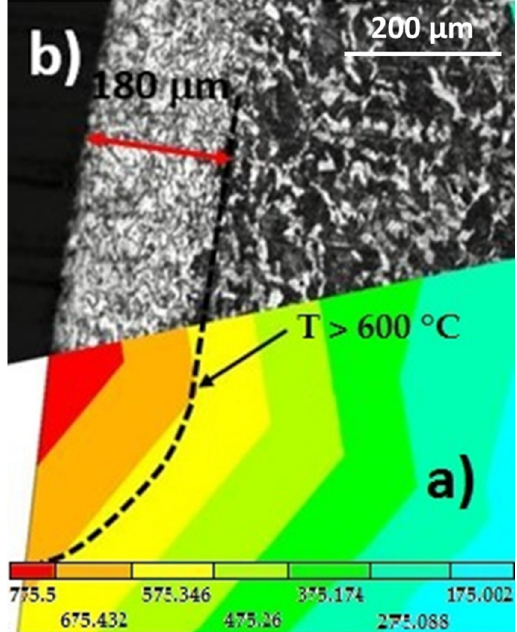
Figure 12. Heat Affected Zone (HAZ) in ( a ) numerical and ( b ) experimental model (Laser power = 200 W and Scan speed = 20 mm/s).